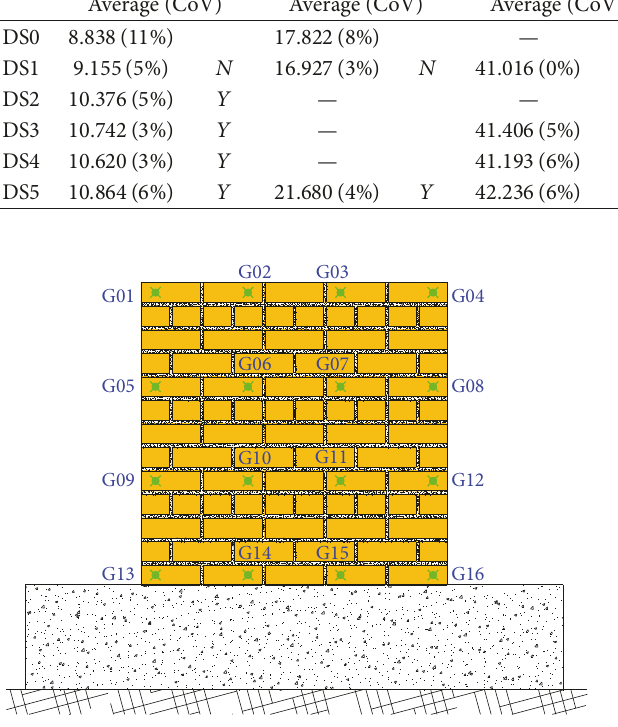
Figure 9: Excitation/measurement